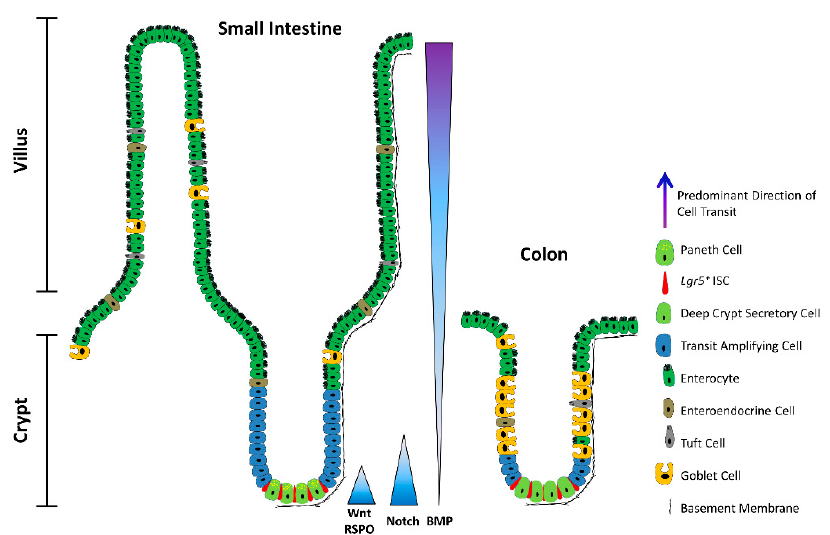
Figure 1 . The architecture of the small intestine and the colon . Schematic depicting a longitudinal section of the intestinal mucosa. The mucosa of the small intestine extends finger-like projections (villi) into the gut lumen, which provide an increased surface area for optimal nutrient absorption. The villi are populated by mature, differentiated absorptive and secretory cell types, including absorptive enterocytes, hormone- and neurotransmitter-secreting enteroendocrine cells, mucus-secreting goblet cells, tuft cells, and microfold (M) cells (not shown). The mucosa surrounding the villi forms tub- ular invaginations into the lamina propria, called crypts, which serve as a protected reservoir of stem and progenitor cell populations. Notably, the epithelium of the colon is devoid of villi, with the crypts opening onto a flat mucosal surface, reflecting its role in waste compaction. To support homeostatic turnover, ISCs self-renew and give rise to short-lived transit-amplifying (TA) cells, which in turn beget lineage-restricted progenitors that differentiate into the mature cell types lining the villi. During their limited lifespan, intestinal epithelial cells migrate from the base of the crypt to the tip of the villus or the colonic surface, from where they are shed into the gut lumen and replaced by neighbouring cells. In contrast, Paneth cells are relatively long-lived, and migrate to the base of the crypt, where they secrete antimicrobial peptides and form a vital component of the ISC niche. Paneth cells are absent from the colon, but deep crypt secretory (DCS) cells may fulfil an equivalent role. Opposing gradients of morphogens specify intestinal-cell fate and differentiation along the ver- tical crypt axis: Wnt and Notch signalling prevail at the crypt base, whereas BMP transduction is highest near the